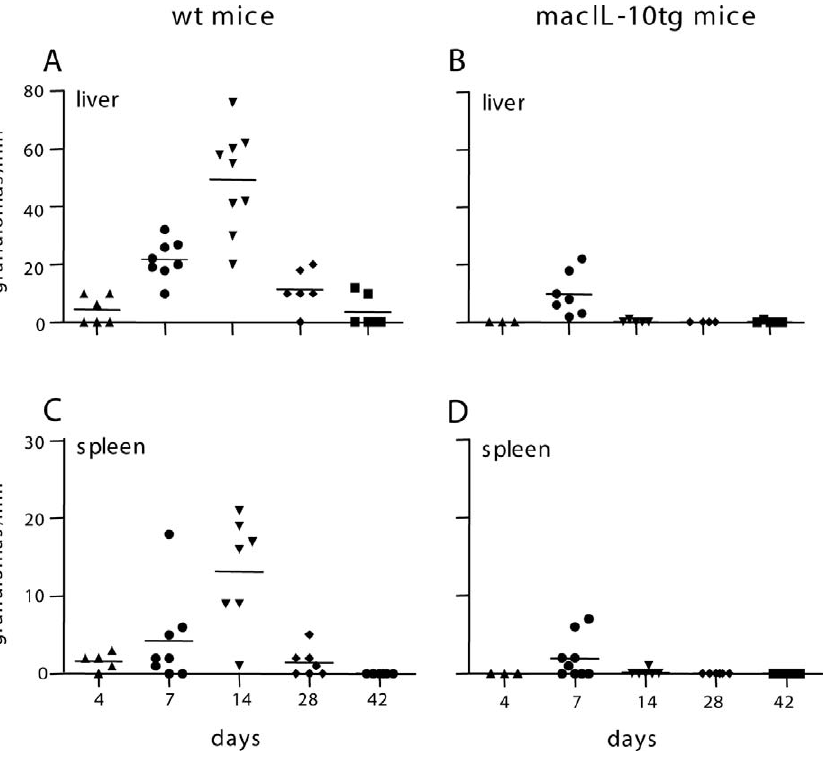
Figure 3. Granuloma Quantification Liver (A and B) and splenic (C and D) granulomas were numbered by image analysis. The results are expressed as the number of granulomas per square millimeter of tissues in wt (A and C) and transgenic (B and D) mice. Bars represent the median of values for each time